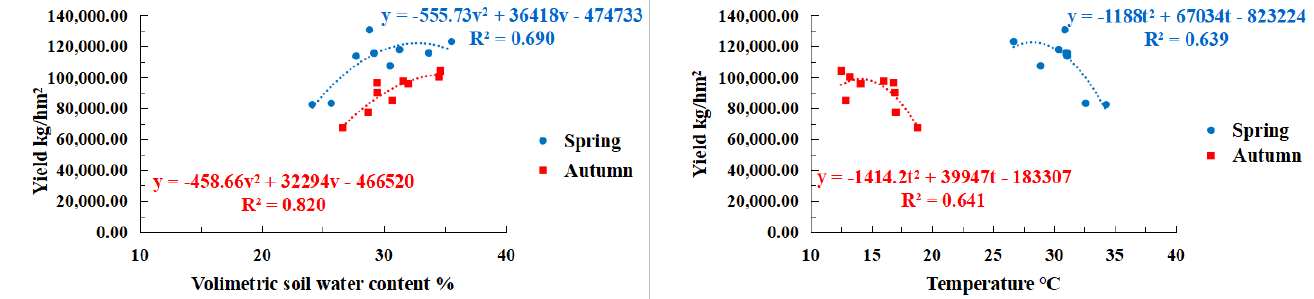
Figure 5. Regression analysis of volume soil moisture content (v), soil temperature (t), and tomato yield (y).